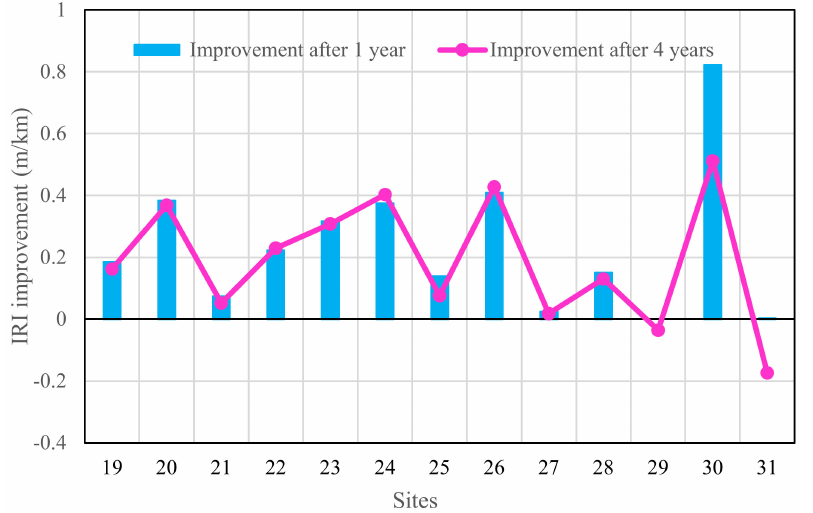
Figure 5. EffectivenessofWMAoverlayscontainingRAPforIRIimprovementunderwetclimaticconditions.